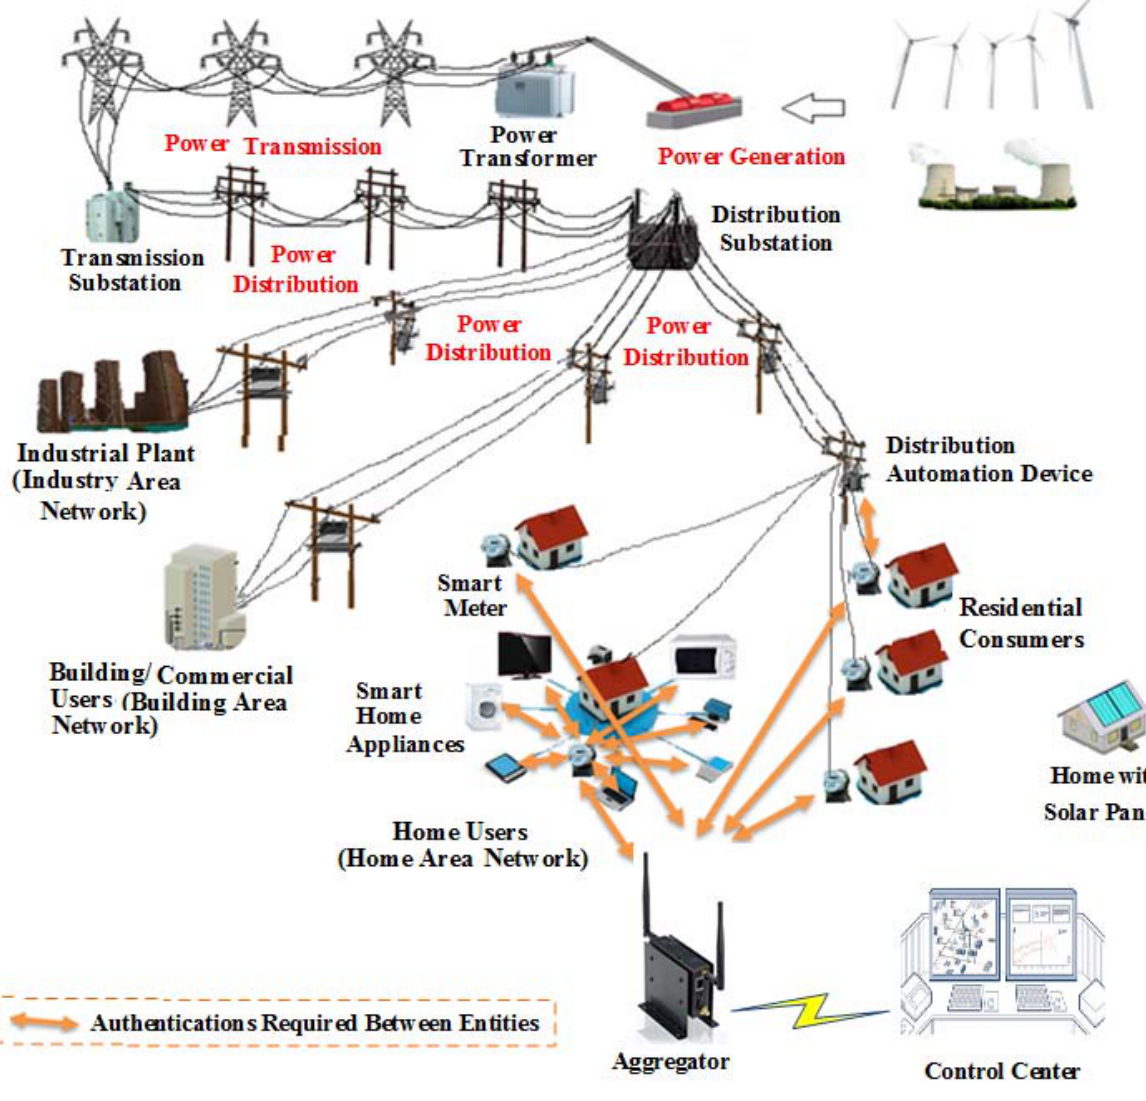
Figure 1. Overview of smart grid (SG) network